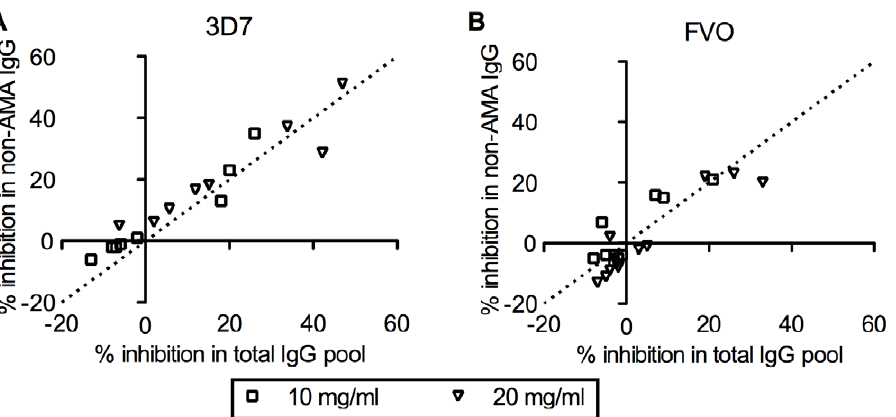
Figure 2. Non-AMA1 IgGs show comparable levels of growth-inhibitory activity as the original total IgG pools. Non-AMA1(3D7) (A) or non-AMA1(FVO) IgGs were tested against P. falciparum 3D7 (A) or FVO (B) parasites at 10 or 20 mg/ml in GIA well. Percent inhibition of non-AMA1 IgG ( y -axis) is plotted against the % inhibition of the original total IgG pool ( x -axis). The dotted line represents y=x line.